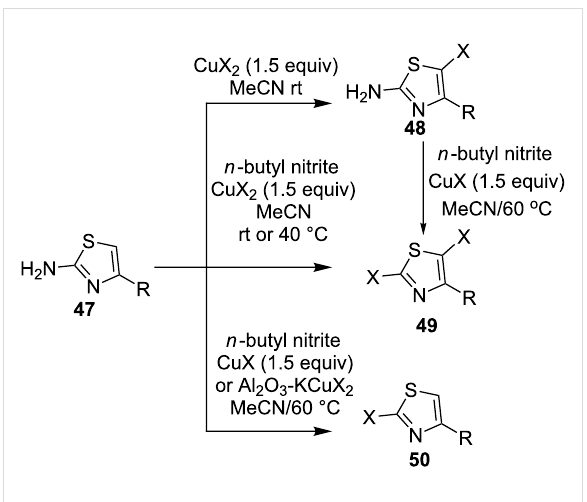
Scheme 17: Copper-catalyzed halogenations of